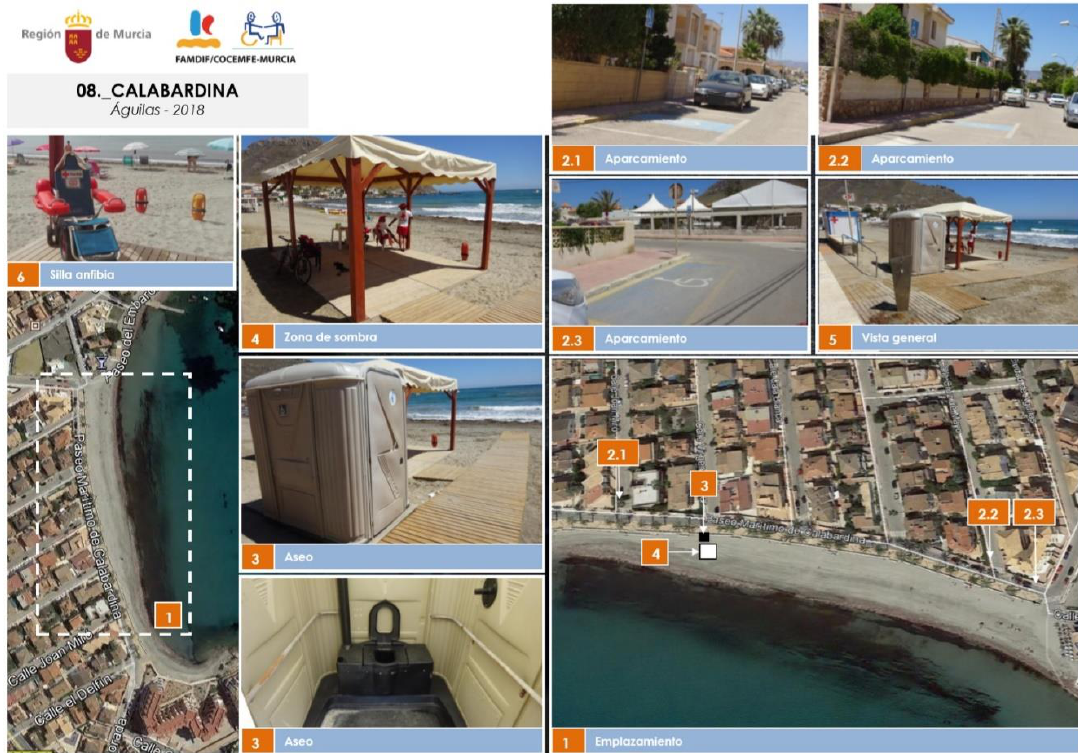
Figure 3. Sample graphical report obtained for the beach of Calabardina (in the municipality of Á guilas) for the 2018 update of the field study. Image extracted from [21].